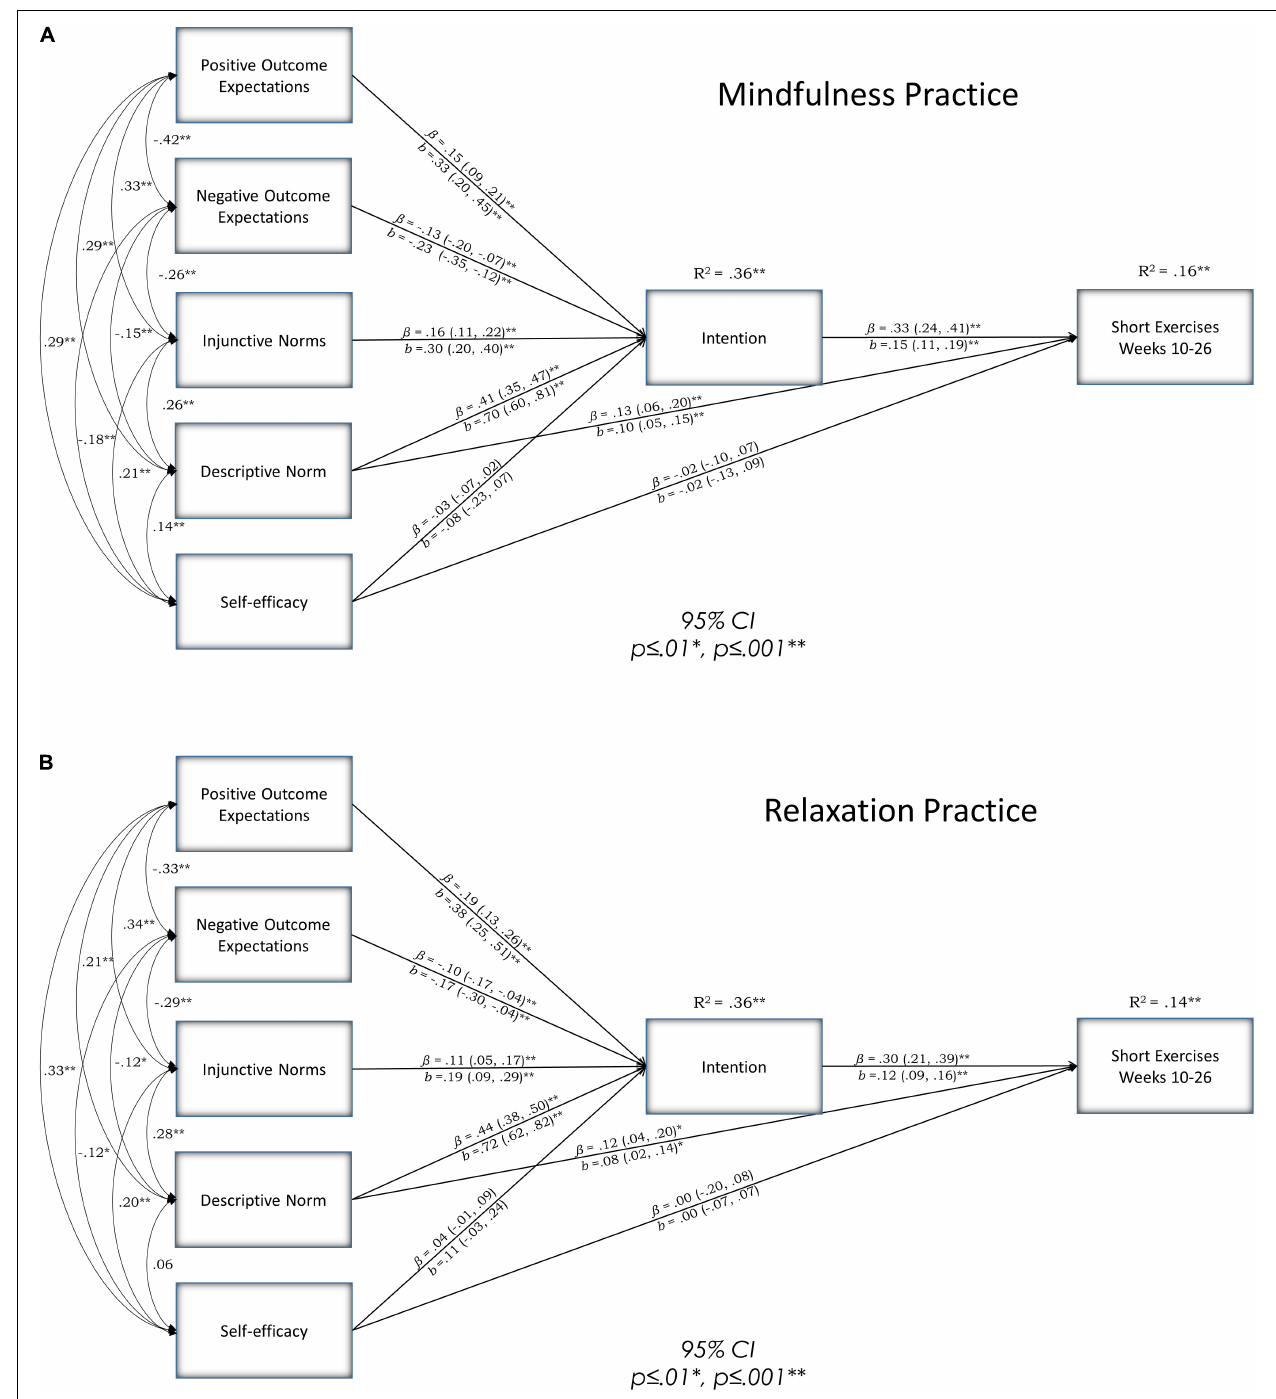
FIGURE 1 | Multi-group path models: (A) Mindfulness and panel (B) relaxation. Results 95% CI, p ≤ 0.01 ∗ , p ≤ 0.001 ∗∗ . The model was adjusted for grade level, i.e., specified to predict intention and practice. Multi-group modeling was used to produce separate parameter estimates for the relaxation and mindfulness arms. All variables except for the practice variables come from the 10-week survey. The practice variables come from the 26-week survey.